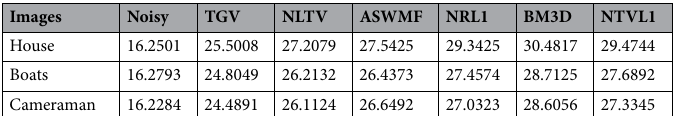
Table 4. The PSNR for TGV, NLTV, ASWMF, NRL1, BM3D and NTVL1 models.